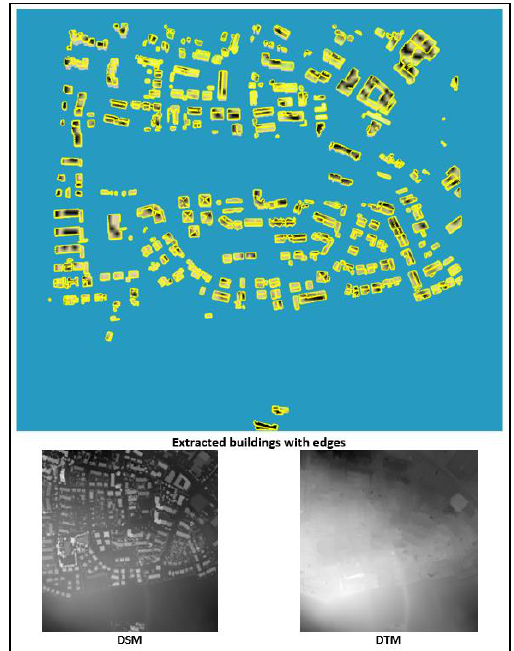
Figure 3. Extracted building boundaries and generated